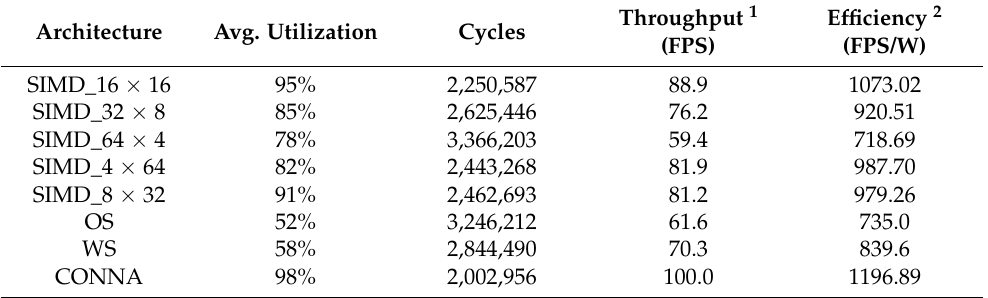
Table 9. Utilization, cycle, and throughput comparison with SIMD and OS/WS-based accelerators.